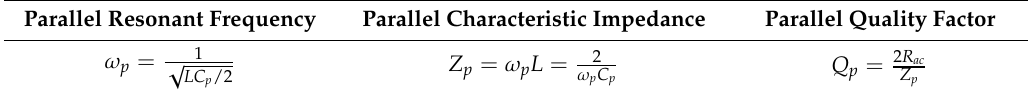
Figure 3. Two-phase LC s C p resonant inverter. Circuit simplified according to the Bisection Theorem. The parallel parameters of the LC s C p inverter are summarized in Table 1. Table 1. Parallel parameters of the LC s C p resonant inverter.